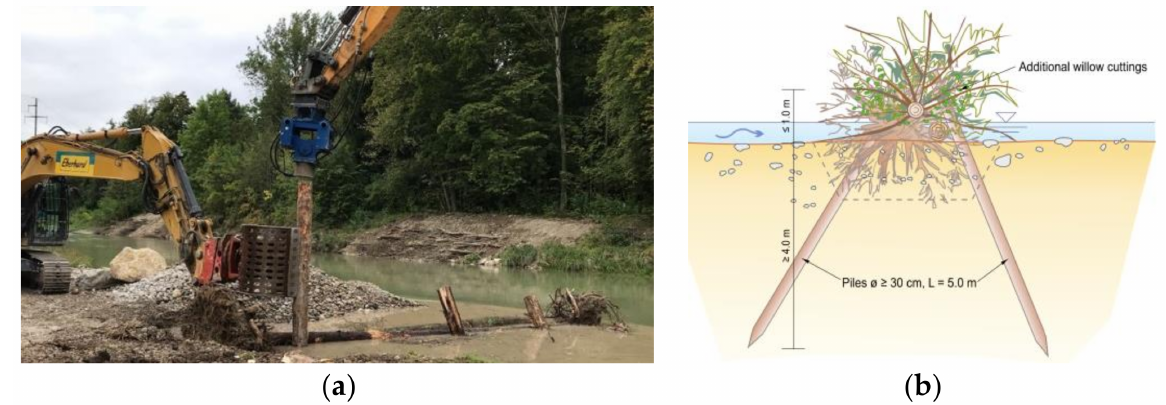
Figure 9. ( a ) Mechanical piling to anchor LW islets in a pebbly riverbed substrate; Emme River; Photo: M. Mende. ( b ) Draft of a LW islet; Emme river; IUB Engineering AG.